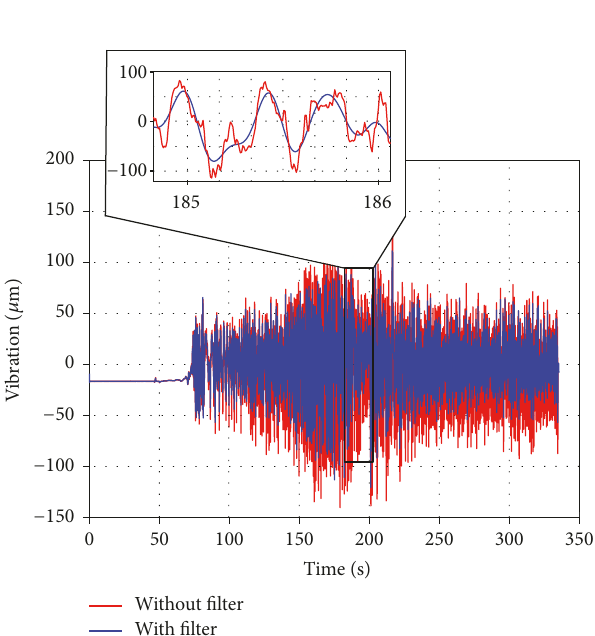
Figure 6: Comparison between original and filtered signals.